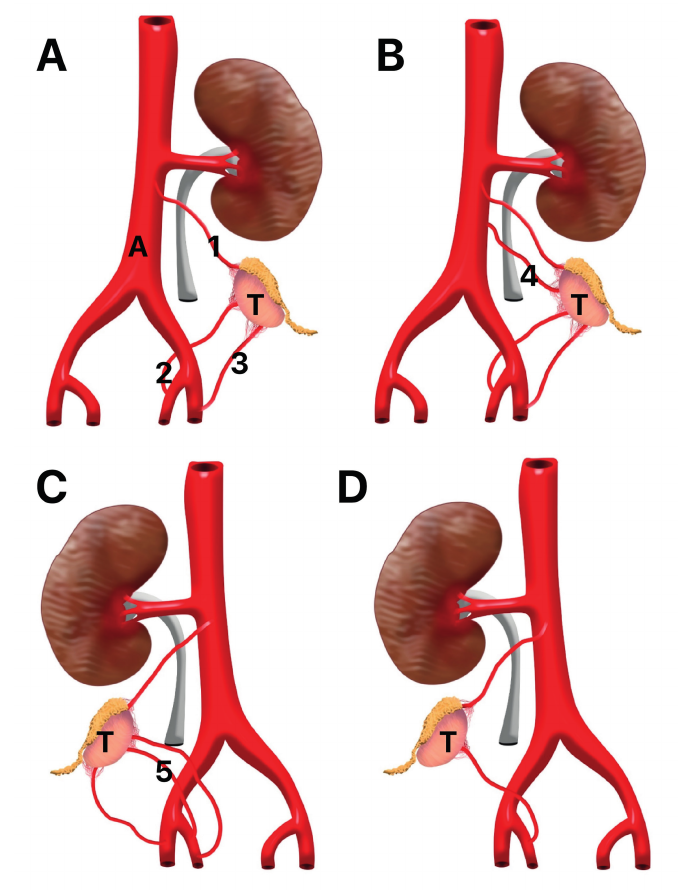
Figure 5 - Testicular vascularization variations in fetuses with the testis in abdominal position. A) Schematic drawing showing the most frequent arterial pattern of testicular vascularization - Testis (T) has three arteries: Testicular (1), Deferential (2) and Cremasteric (3); B) Schematic drawing showing testicular vascularization with four arteries, we can observe an anatomical variation - presence of a second testicular artery (4) originated at the aorta artery; C) Schematic drawing showing testicular vascularization with